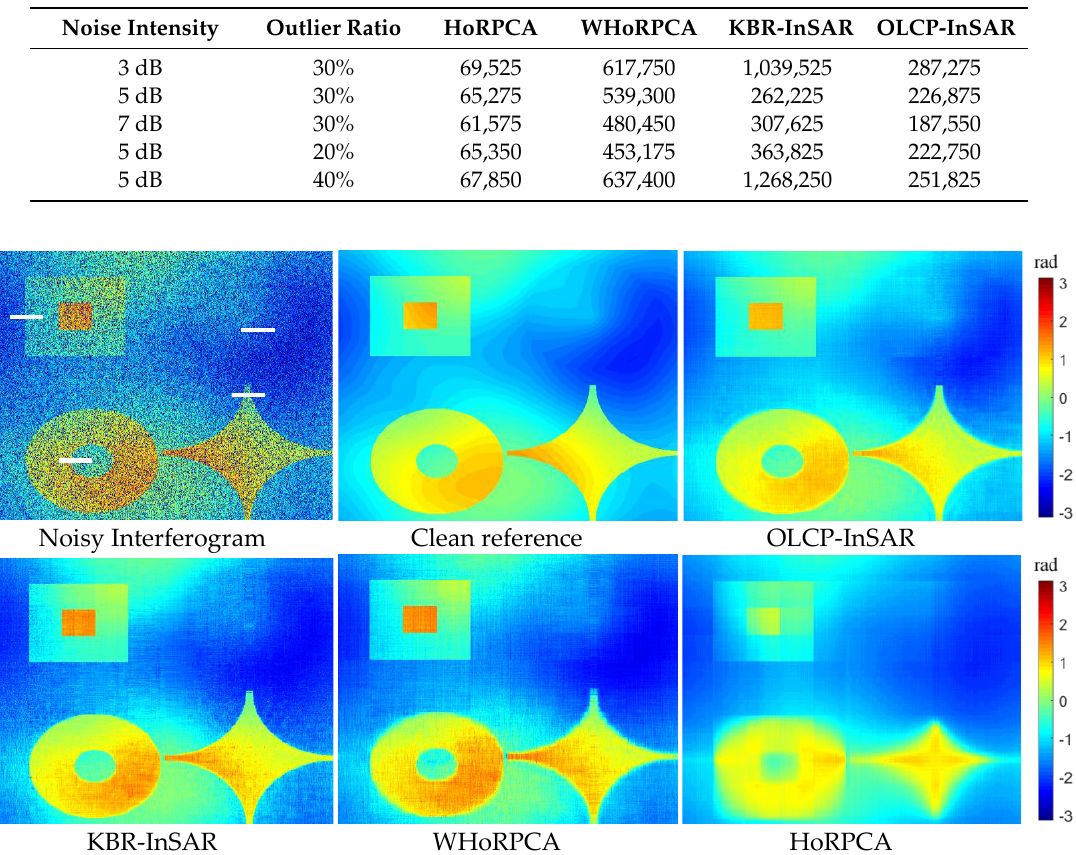
Figure 10. The filtered result of tensor-based filtering methods. The white short line on the noisy interferogram is the selected profile and the filtered results of these profiles are shown in Figure 6. Table 1. The mean square error (MSE) of filtered tensors with different noise conditions.